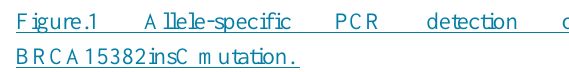
Allele-specific detection